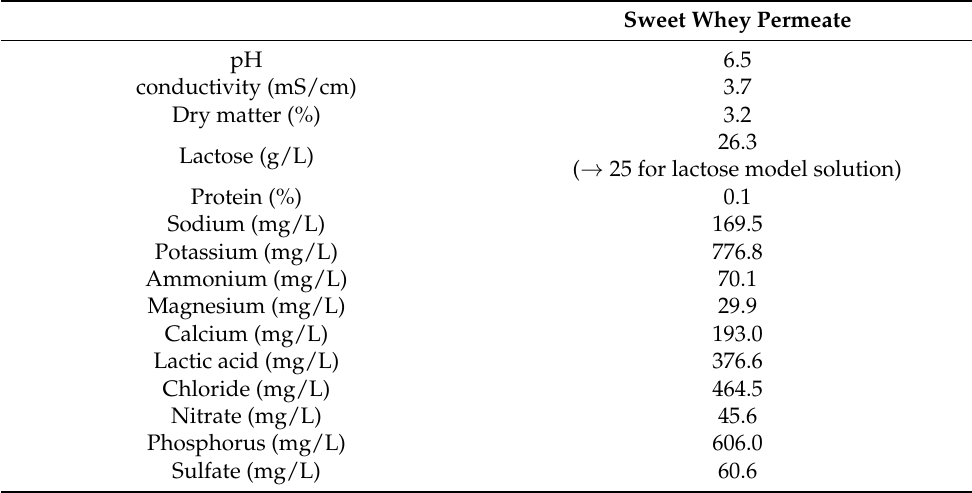
Table 1. Average composition of the sweet whey permeate